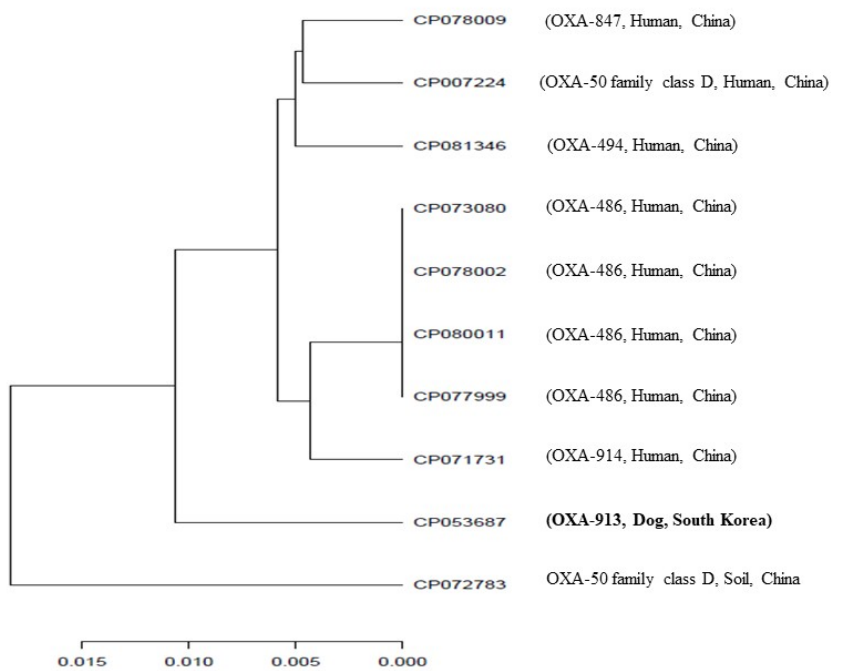
Figure 1. Comparative analysis of chromosomal regions (1 Mb) of the bla OXA-913 gene and OXA-50 family class D genes. ANI analysis was performed using the ANI-blast method implemented in PYANI (v.0.2.10) and the tree was generated based on the ANI values. The horizontal lines represent the 95% threshold value. The scale bar represents sequence divergence, i.e., the percentage of nucleotide substitution rate over the length of the genome.